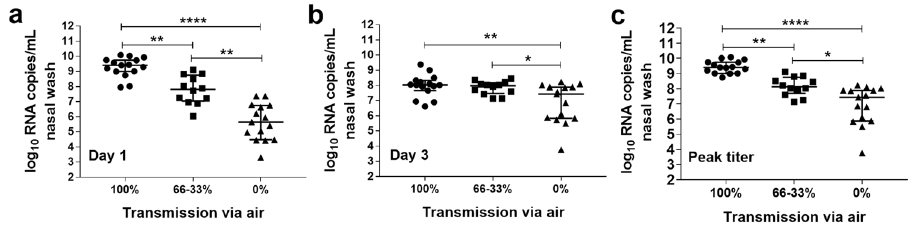
Fig. 4 Comparison of viral RNA levels detected in nasal wash samples from ferrets inoculated with in fl uenza A viruses displaying diverse transmission capabilities. Viral RNA copies in nasal wash samples collected from inoculated ferrets on day 1 p.i. a , day 3 p.i. b , or peak titer (either d1 or d3 p.i.) c are shown. Data were grouped by virus transmissibility pro fi le in the ferret model (100%-transmission between all ferret pairs [A/Idaho/07/2018 A(H1N1) pdm09, A/Michigan/45/2015 A(H1N1)pdm09, A/Nebraska/14/2019 A(H1N1)pdm09, A/Michigan/288/2019 A(H1N1)v, A/Minnesota/45/2016 A(H1N2)v (3 ferrets per virus; n = 15)], 66 – 33% - transmission between 2/3 or 1/3 ferret pairs [A/Anhui-Lujiang/39/2018 A(H9N2), A/California/62/ 2018 A(H1N2)v, A/Ohio/24/2017 A(H1N2)v, A/Ohio/09/2015 A(H1N1)v (3 ferrets per virus; n = 12)], 0% - no transmission via air or inef fi cient direct contact transmission if airborne transmission was not tested [A/Ohio/02/2007 A(H1N1)v, A/turkey/California/18-031151-4/2018 A(H7N3), A/Sichuan/ 26221/2014 A(H5N6), A/Yunnan/14563/2015 A(H5N6), A/duck/Bangladesh/19D770/2017 A(H5N6) (3 ferrets per virus; n = 15)]. Kruskal – Wallis one- way analysis of variance (ANOVA) with Dunn ’ s post-test were used to determine signi fi cant differences, * p < 0.05, ** p < 0.01, *** p < 0.001, **** p < 0.0001. Data points represent individual ferrets. Error bars represent median with